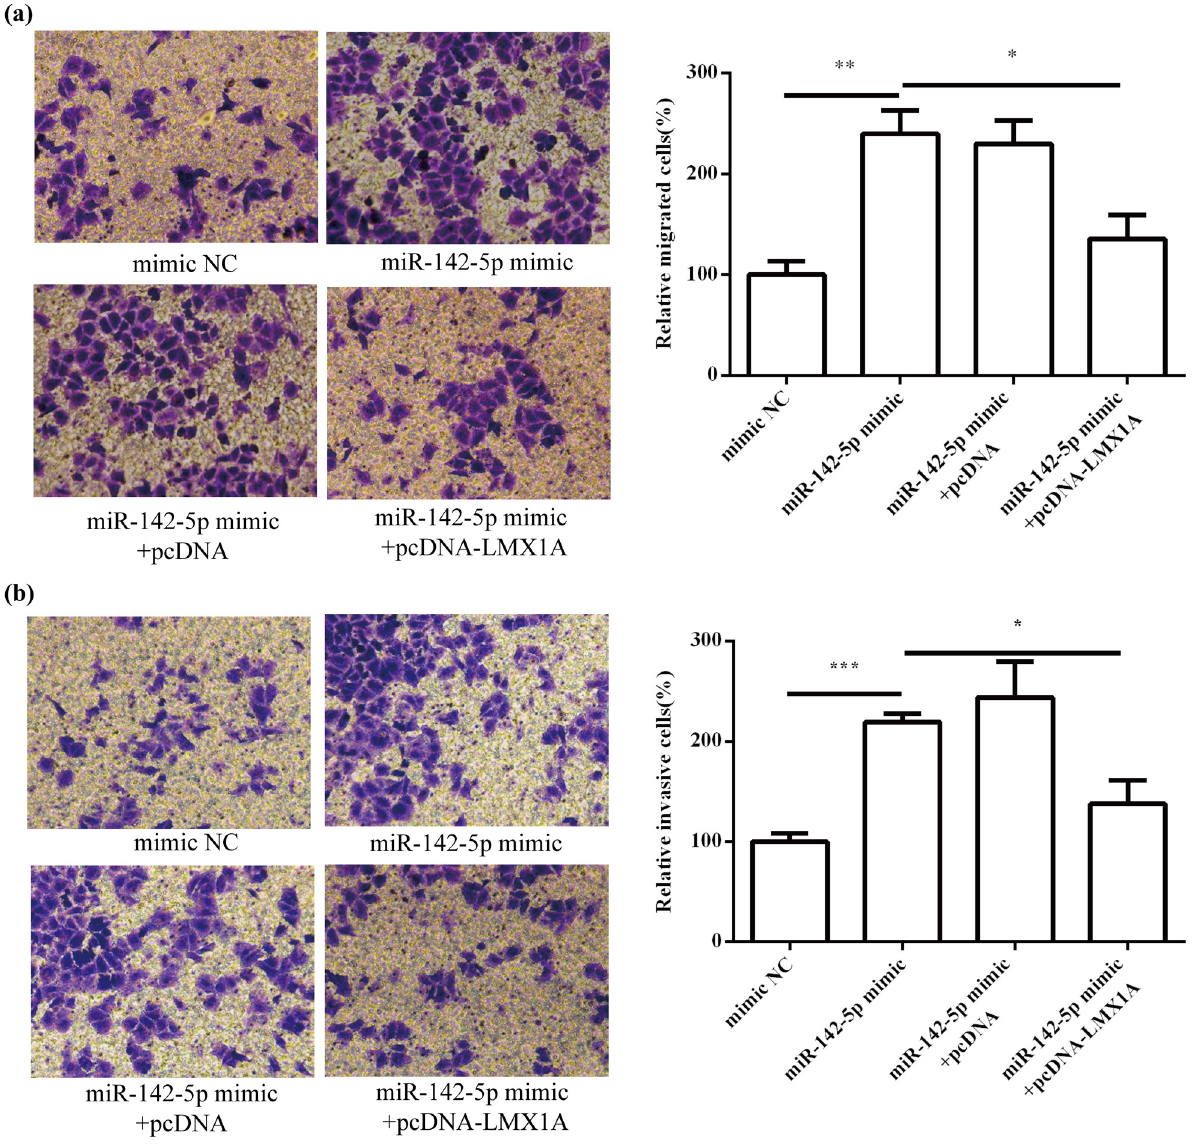
Figure 9: miR - 142 - 5p a ff ected HeLa cell migration ( a ) and invasion ( b ) by targeting LMX1A. All experiments were performed in triplicate. * P < 0.05. ** P < 0.01. *** P <